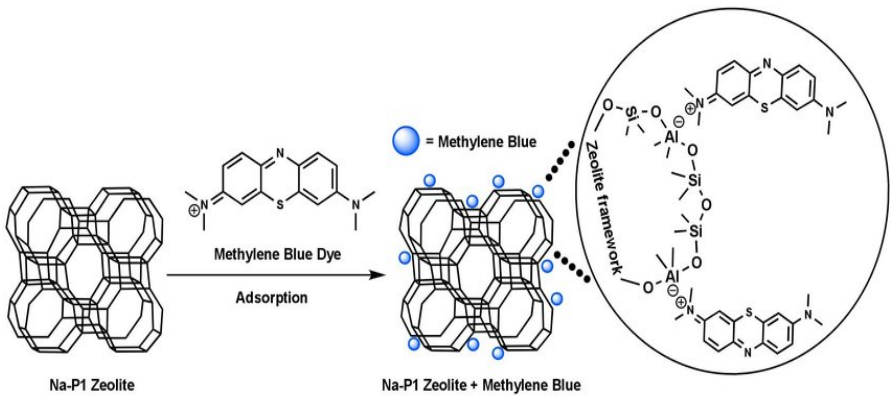
Figure 7. Adsorption of methylene blue on Na-P1 zeolite. Reprinted from Ref.